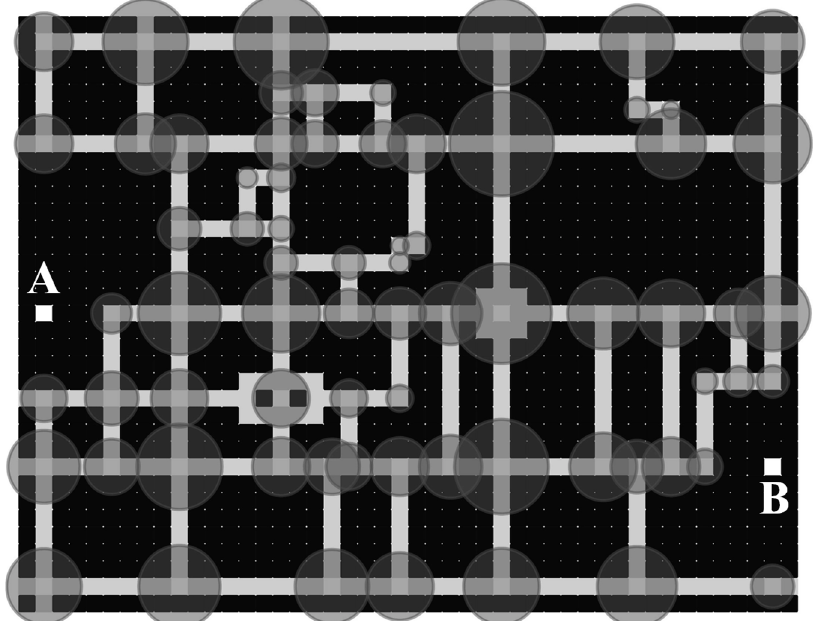
Figure 13. Evaluation results of the accessibility of each node at time t .